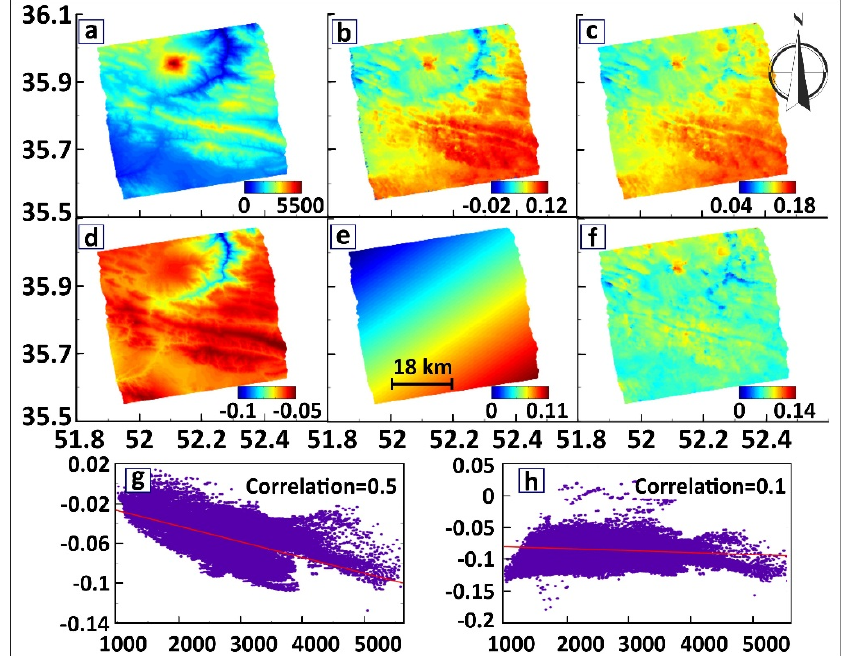
Figure 3. Atmospheric and orbits/ionosphere correction for ALOS interferometric pair of 24 July 2007 and 13 September 2009. ( a ) SRTM DEM, elevation in meters; ( b ) Original interferogram. ( c ) Differenced wet delay map along LOS direction derived from GPS data and elevation-dependent interpolator; ( d ) Corrected interferogram after removing tropospheric effects; ( e ) Estimated orbit/ionospheric ramp; ( f ) Corrected interferogram after removing orbits/ionosphere effects. Note that negative values imply the ground surface moves away from the satellite and positive values move toward the satellite (colorbar in meter). ( g ) and ( h ) illustrate correlation between interferometric phase (original and corrected) and SRTM Digital Elevation Model, corresponding to (b) and (f)